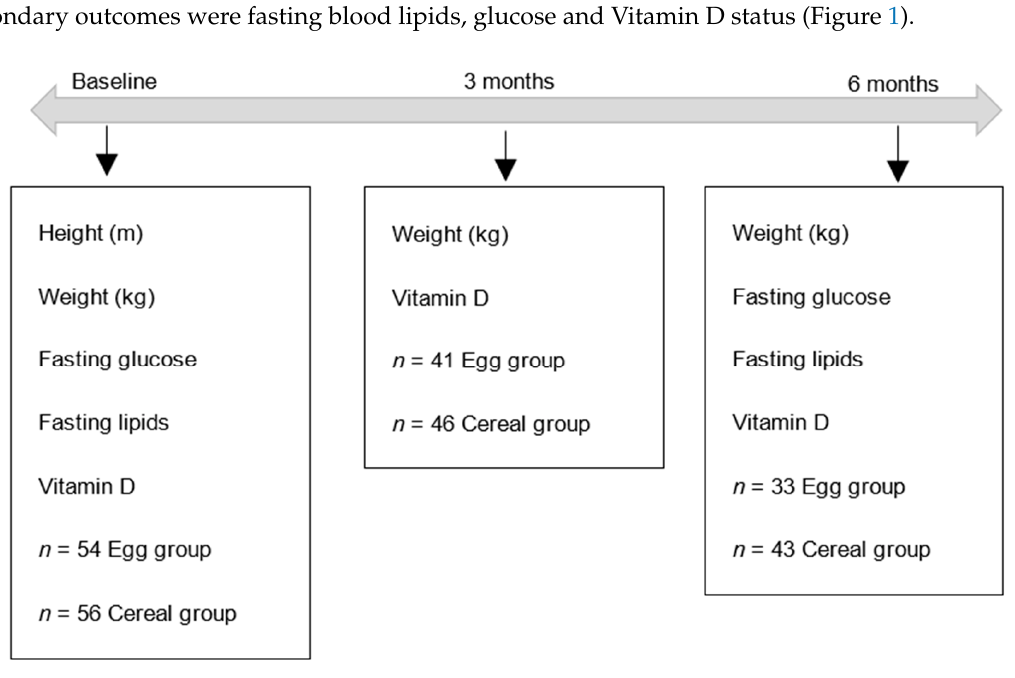
Figure 1. Flow chart of timeline, sample size at each timepoint and variables measured. Participants were >18 years, overweight (BMI > 25 kg/m 2 ). Exclusion criteria were previous surgery for weight reduction; type 1 or type 2 diabetes; women who were or wished to become